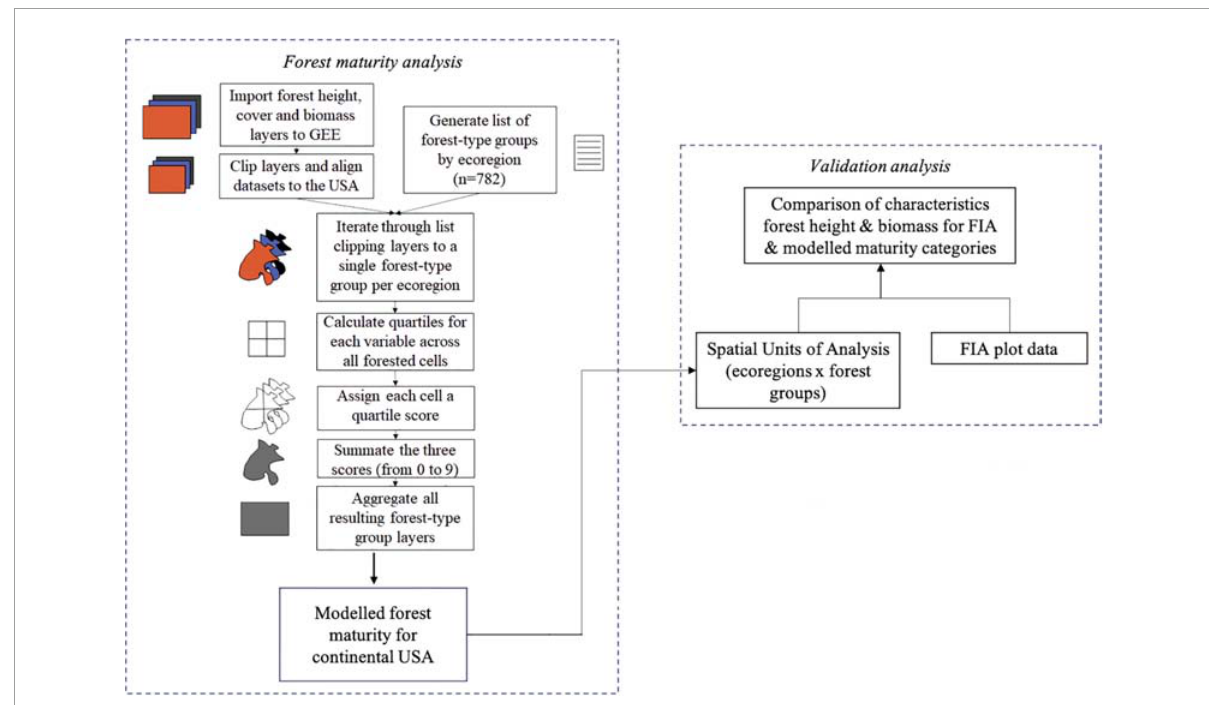
FIGURE1 Workflow showing main steps in the calculation of the forest maturity structure model for conterminous United States, along with the validation analysis. The three 30-m resolution spatial data sets for forest cover, canopy height, and biomass were analyzed within 872 spatial units of analysis (SUA) defined by the intersection of ecoregions and major forest types. Forest Inventory Analysis (FIA, 2022) plot data were used for a validation analysis. Further details in Supplementary Information